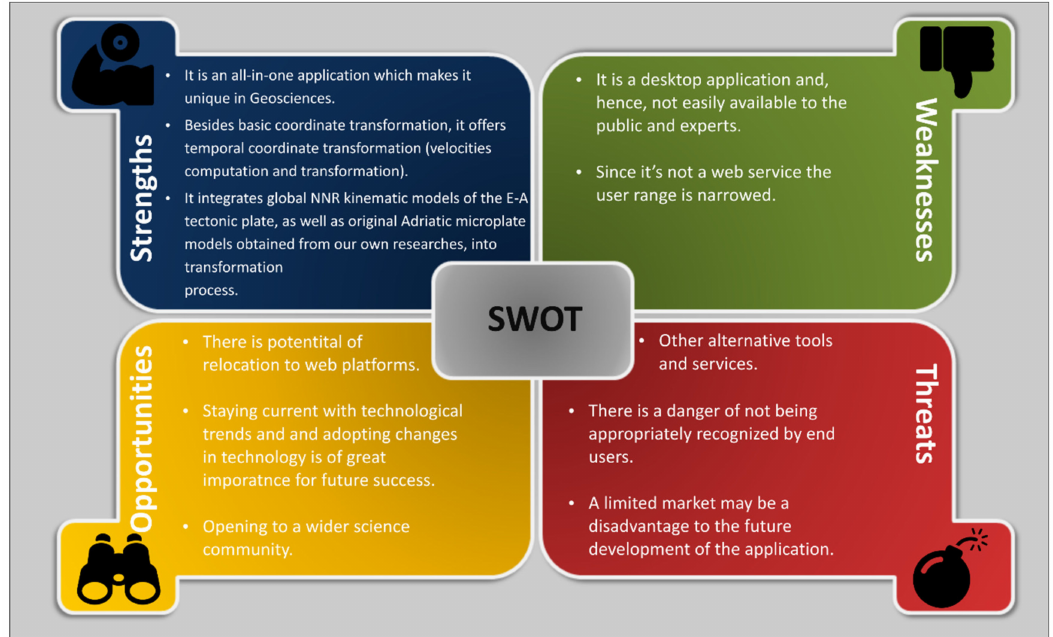
Figure 7. Graphical presentation of SWOT (strengths, weaknesses, opportunities, threats) analysis of the TranSAB